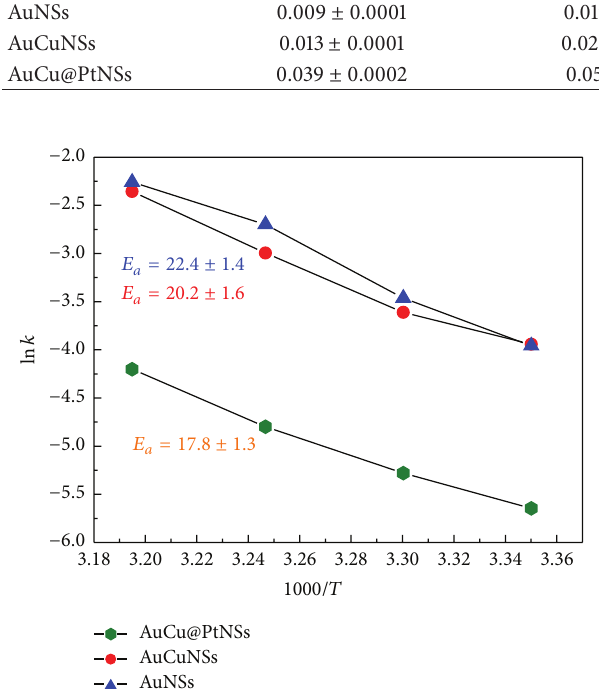
Figure 4: Arrhenius plots for the catalytic reduction of 4- nitrophenol with 100mM BH at temperatures of 25 ∘ C, 30 ∘ C, 35 ∘ C, and 40 ∘